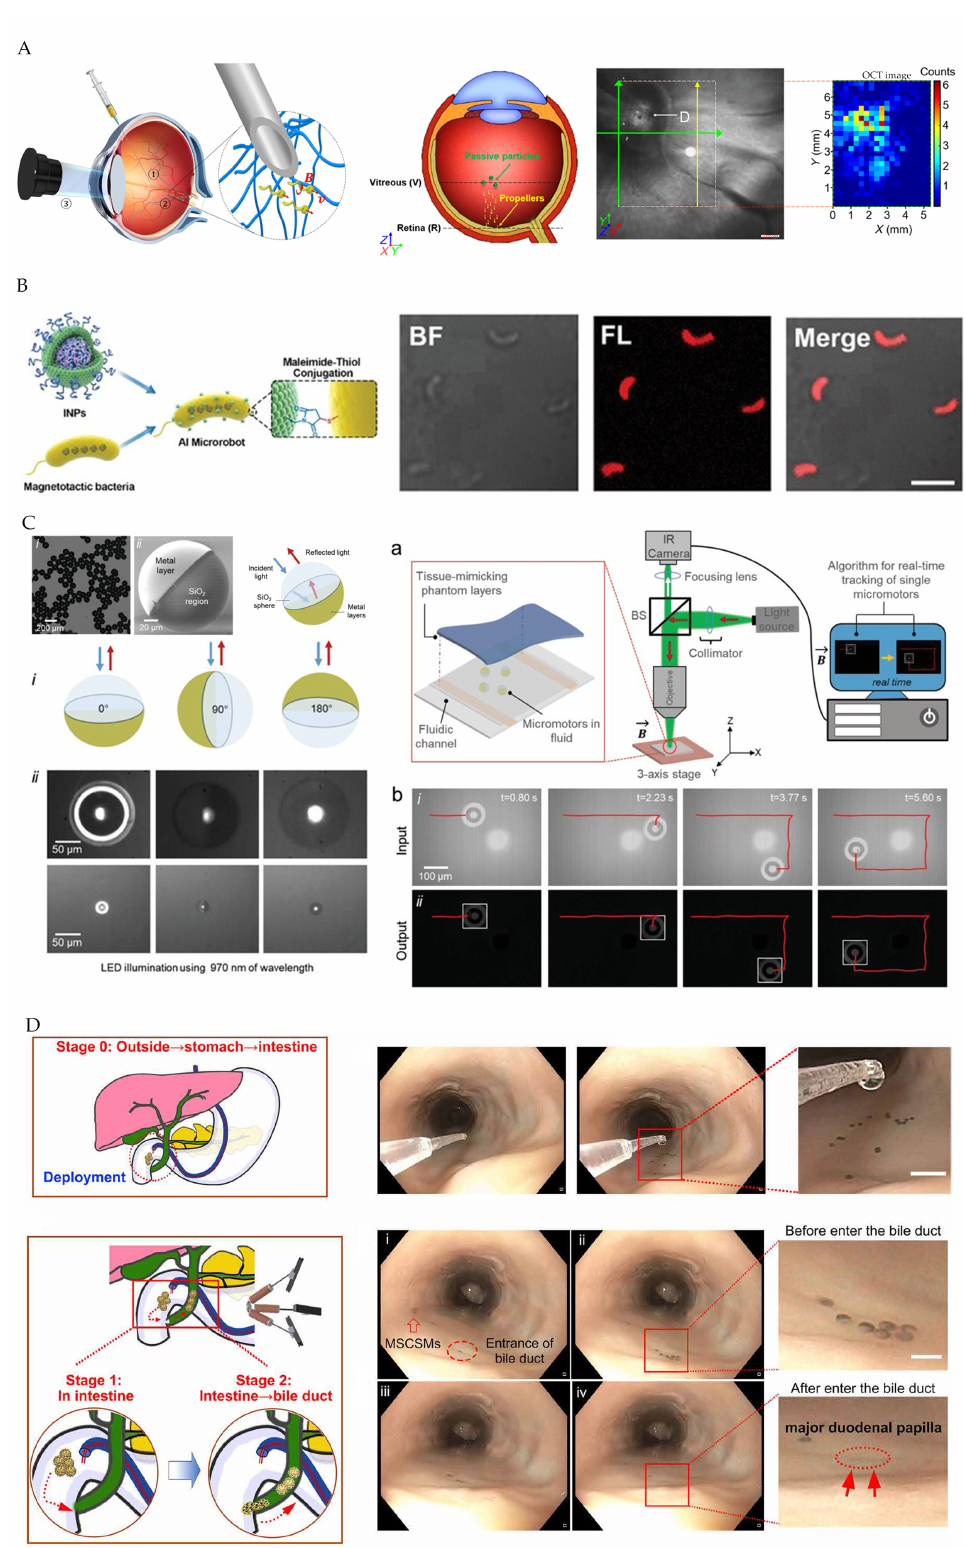
Figure 8. ( A ) Microrobot localized with OCT imaging. Reproduced with permission from [6]; published by AAAS, 2018. ( B ) Magnetic biomicrorobot tracked by fluorescence imaging. Reproduced with permission from [74]; published by John Wiley and Sons, 2021. ( C ) Single reflective micromotors tracked by real-time IR imaging. Reproduced with permission from [75]; published by John Wiley and Sons, 2019. ( D ) Endoscope-assisted tracking microrobot. Reproduced with permission from [76]; published by AAAS,